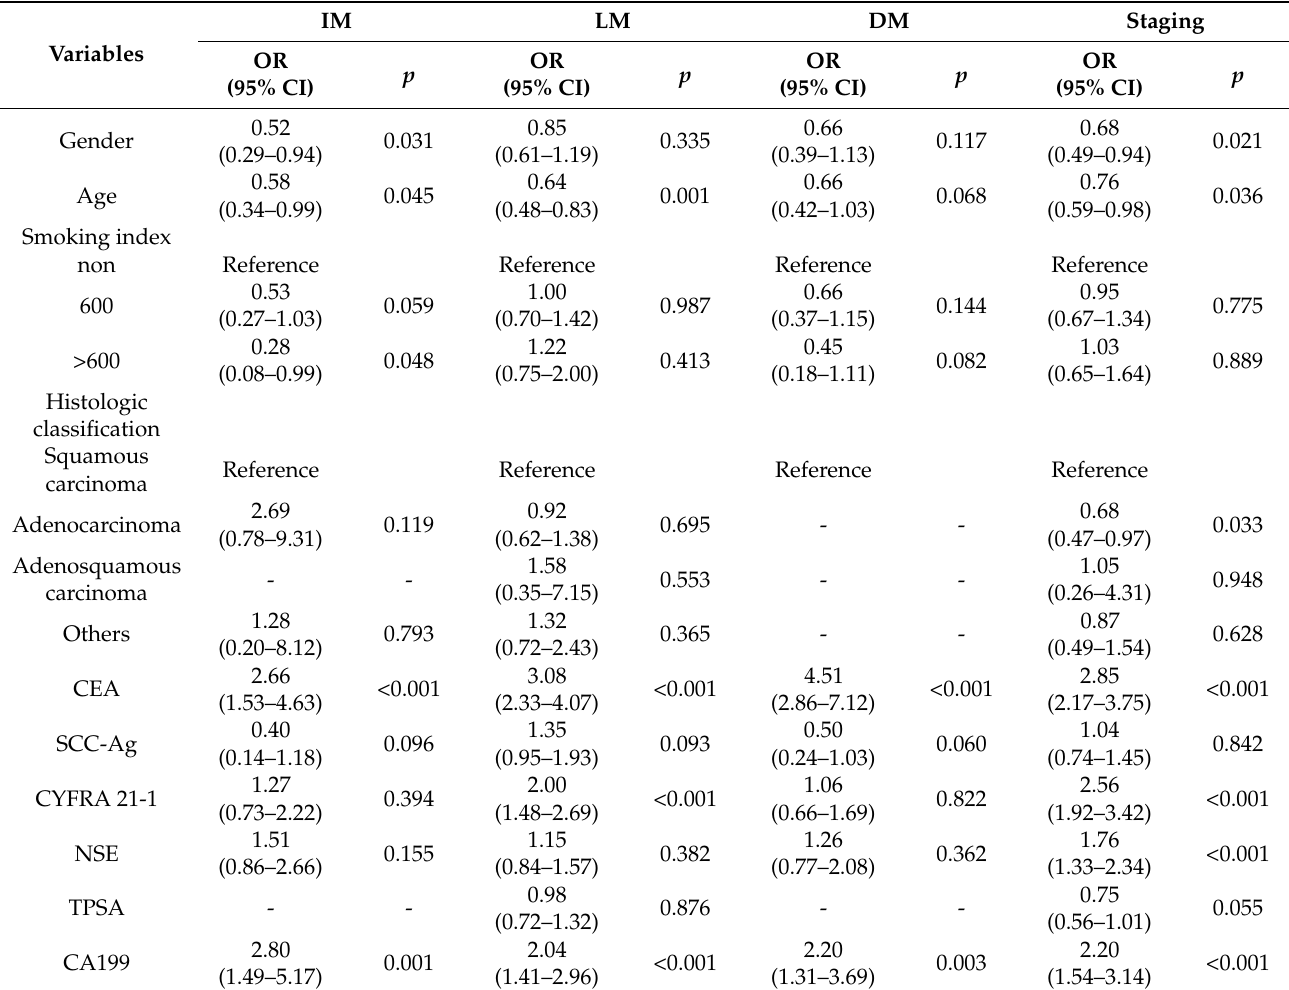
Table 7. Multivariate analysis of influencing factors for tumor metastasis and clinical stage in patients with